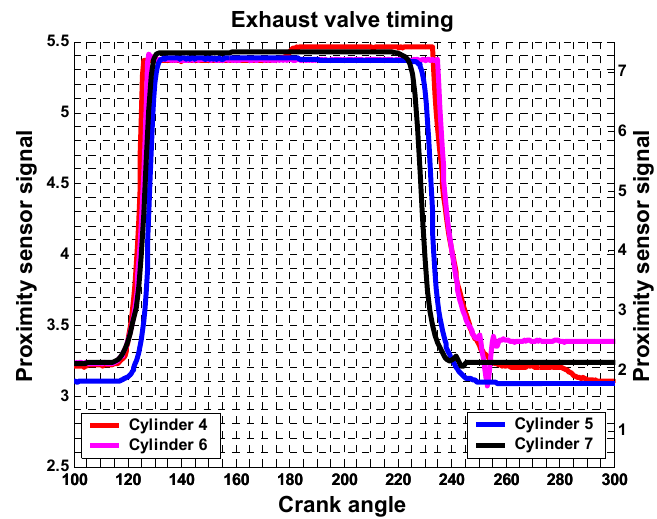
Figure 8. Exhaust valve opening profile vs. crank angle degrees (aTDC).